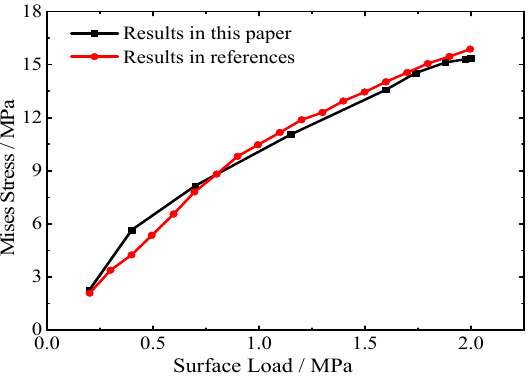
Figure 9. Variation of von Mises stress along arch camber line with load [16].